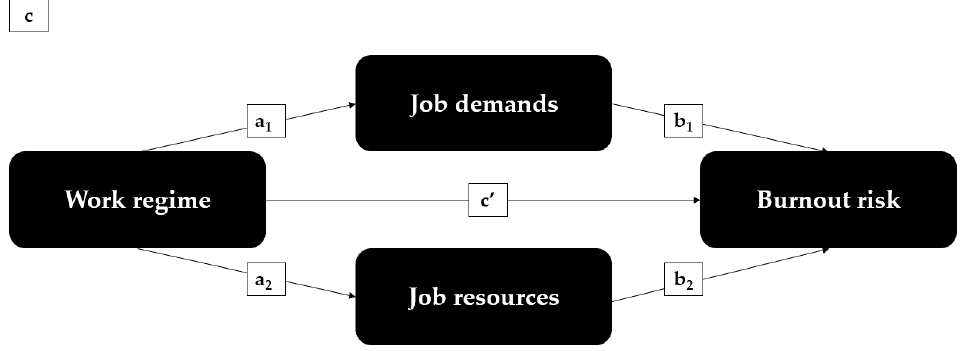
Figure 1. Conceptual framework.